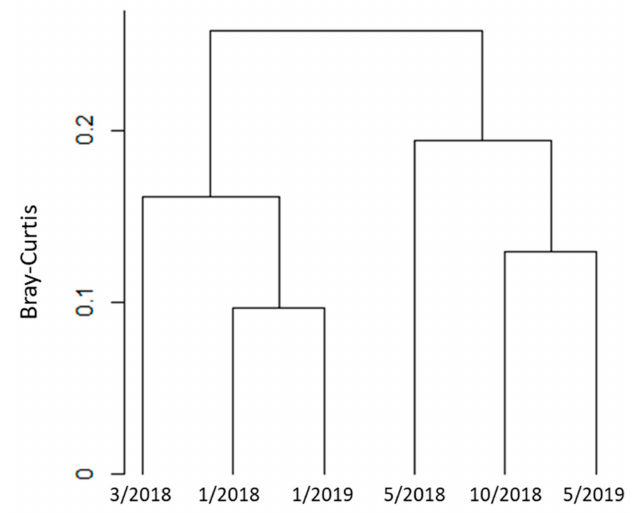
Figure 4. Dendrogram based on cluster analysis of the Bray–Curtis distance. The tips represent six trapping dates (month/year format) in the San Juan Metropolitan Area, Puerto Rico. The y-axis represents the Bray–Curtis distance estimated from vertebrate species diversity identified through mosquito blood